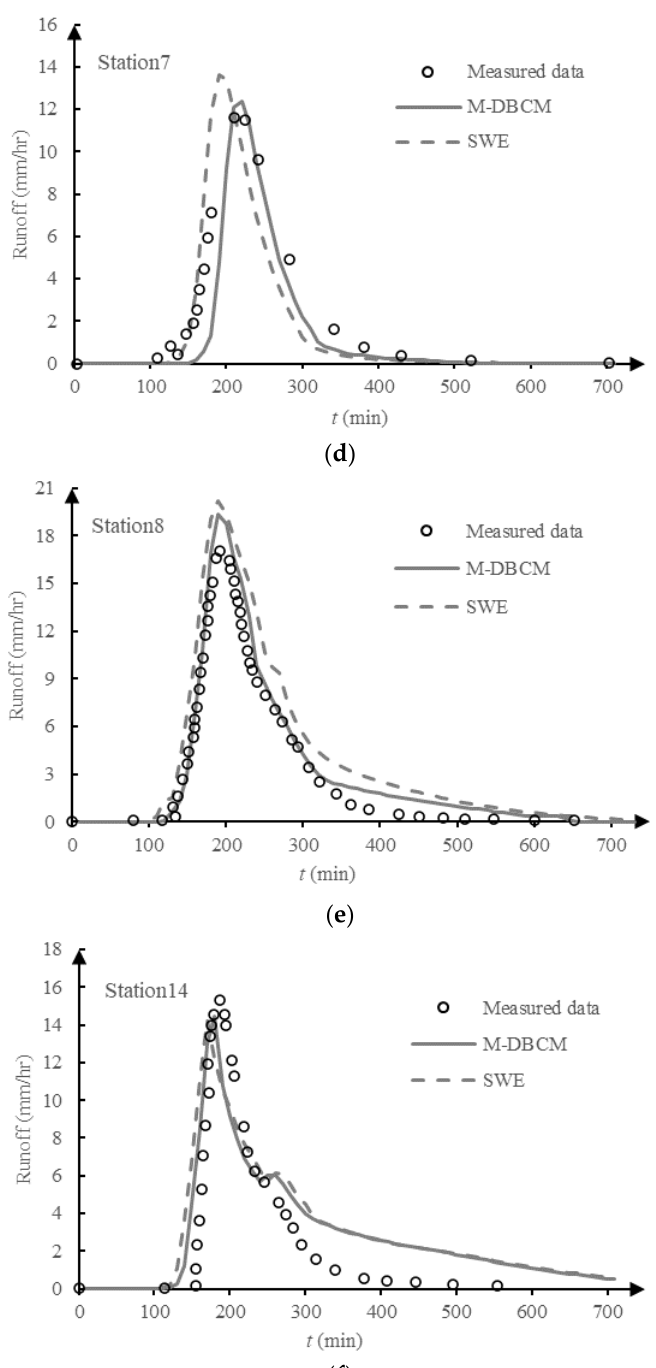
Figure 20. Discharge hydrographs obtained from different models of the watershed. ( a ) Station 1; ( b ) Station 4; ( c ) Station 6; ( d ) Station 7; ( e ) Station 8; ( f ) Station 14. To quantify the error of each model, the root mean square error (RMSE) was used in this study. The RMSE is used to measure the deviation between the observed value and the true value. A smaller RMSE indicates higher accuracy. If the RMSE is 0, the observed value is equal to the true value. If the RMSE is less than half of the standard deviation of the observed value, it indicates that the performance of the model is good. The calculation of the RMSE was as follows: